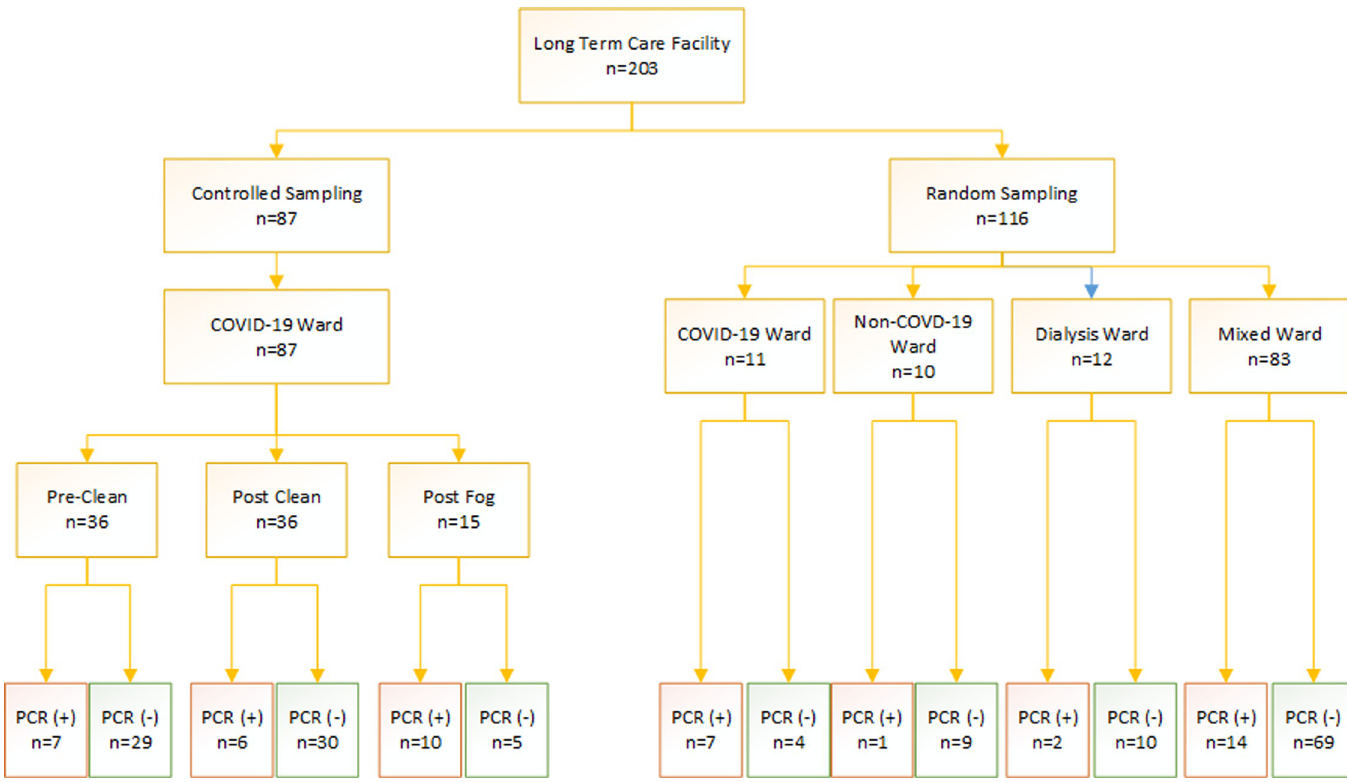
Fig 3. Sample breakdown at the long-term care facility. Legend: Fog = Chemical fogging of room.